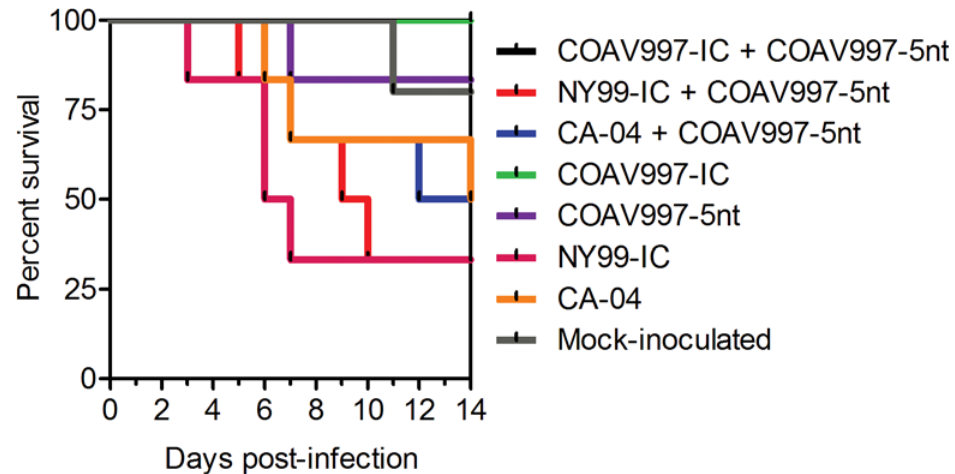
Fig 2. HOFI mortality rates. The percent survival of HOFIs (y-axis) is shown for each experimental group over the course of 14 dpi (x-axis). The lower the survival indicated by percent decrease, the higher the mortality rate in that